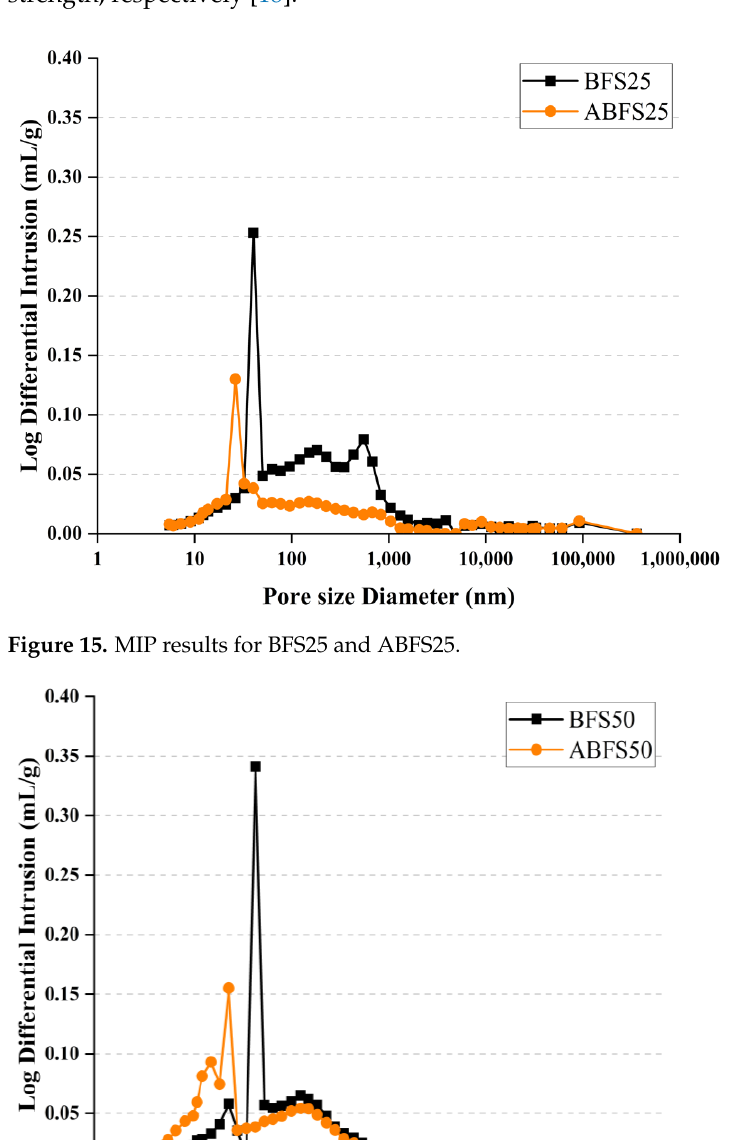
Figure 17. Porosity results for BFS25 and ABFS25.